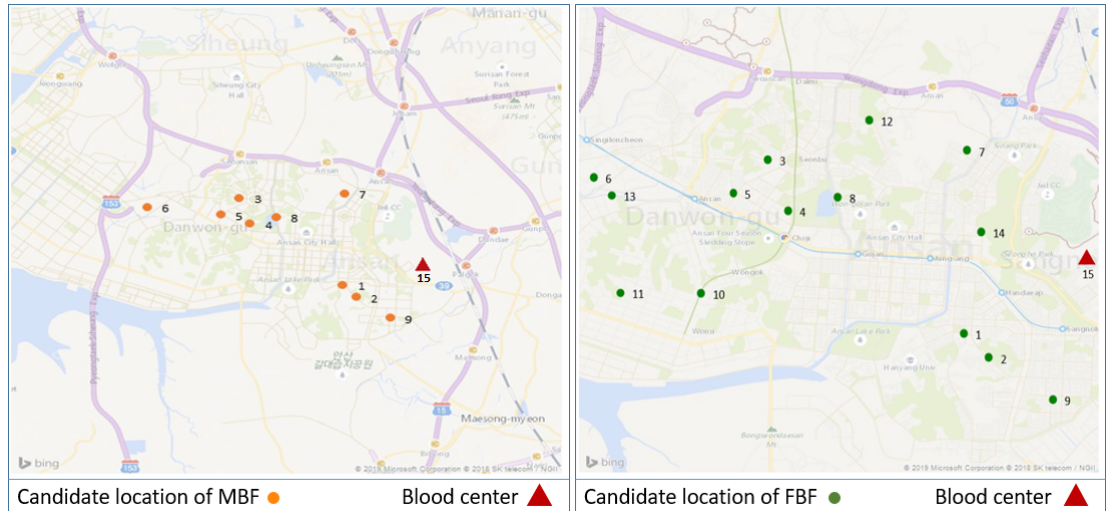
Figure 3. Candidate locations of mobile and fixed blood facilities.